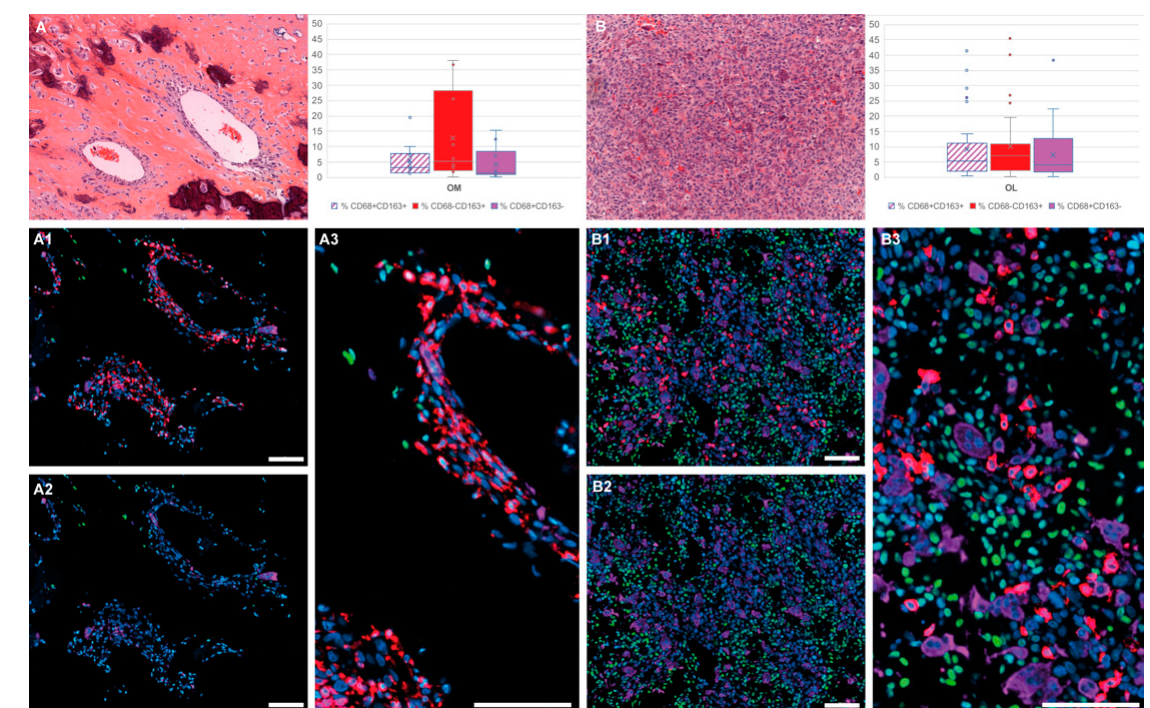
Figure 1. Macrophage and osteoclast population studied by multiplex immunohistochemistry. Histological and immunofluorescent representation of osteoid matrix forming (A, OM), osteolytic (B, OL) tumor regions in OS. ( A ) and ( B ) Representative region demonstrated with Hematoxylin and eosin staining (H&E). The histograms represent the percentage of the different cell populations in OM (left) and OL (right) regions: CD68+CD163+ (dashed white/red), CD68 − CD163+ (red), CD68+CD163 − (purple). ( A ) Histological and immunofluorescent ( A1 – A3 ) representation of cell populations present in OM tumor regions of OS. These regions are characterized by low SATB2-density ( A1 – A3 , green) and a predominant CD163+ macrophage population ( A1 – A3 , red) (CD68+ osteoclasts: purple). ( B ) Histological and immunofluorescent ( B1 – B3 ) representation of cell populations present in OL tumor regions of OS. These regions are characterized by high SATB2-density ( B1 – B3 , green) and a predominant CD163+ macrophage population ( B1 – B3 , red) and an important osteoclast-infiltrate ( B1 – B3 , purple). Hoechst or hematoxylin nuclear counterstain: Blue. Scale bar A1-A2-A3, B1-B2-B3: 100 µm.